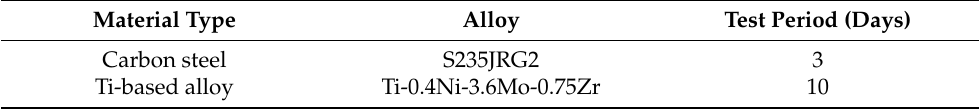
Table 3. The testing periods for the two testing materials.